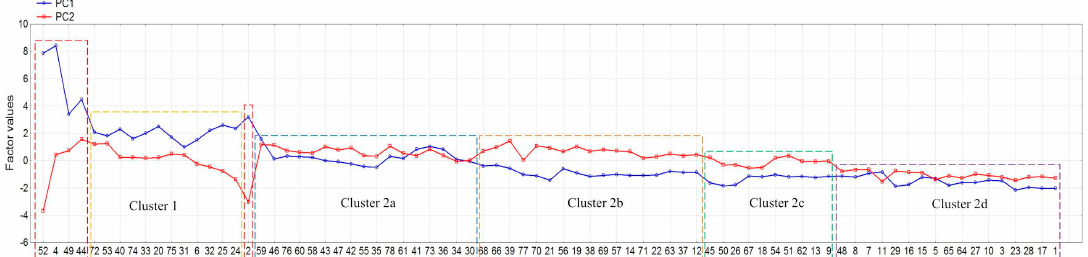
Figure 5. Score plot of PC1 versus PC2 for sampling points.